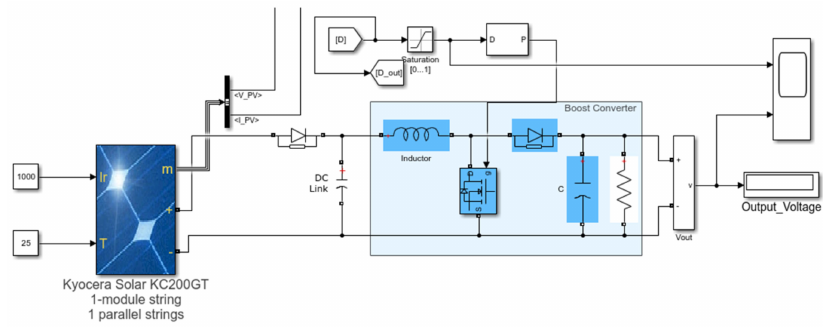
Figure 17. The PV system model in